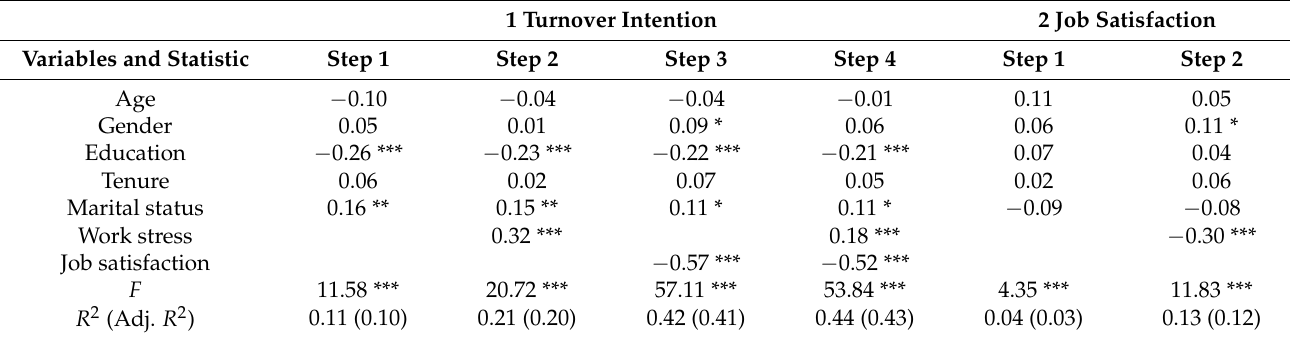
Table 2. Hierarchical regression results for testing